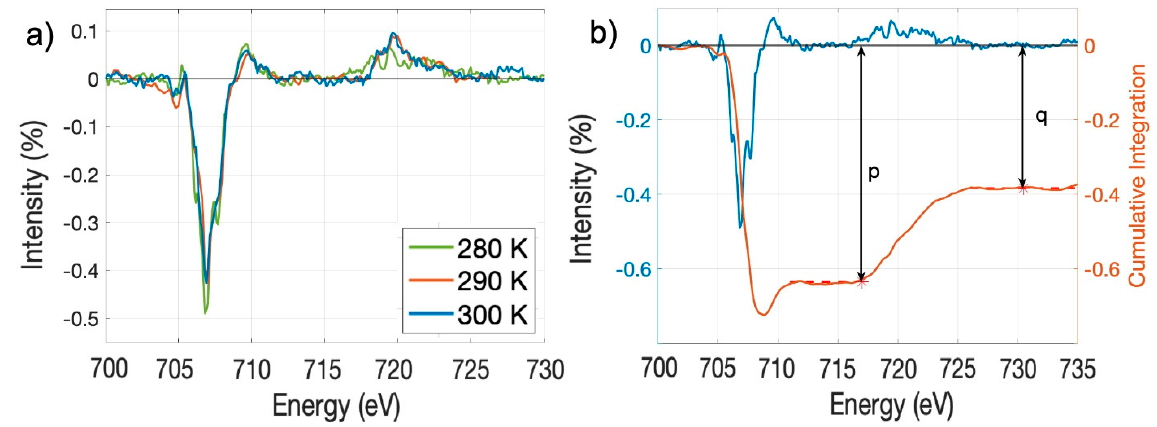
Figure 3. The Fe 2p 3/2 and 2p 1/2 (L 3 and L 2 edges) XMCD spectra of 30 nm [Fe{H 2 B(pz) 2 } 2 (bipy)] thin films on graphite. ( a ) The spectra were taken at 280 K (green), 290 K (red) and 300 K (blue). ( b ) The Fe 2p 3/2 and 2p 1/2 (L 3 and L 2 ) XMCD spectrum taken at 280 K (blue curve) compared to the integrated XMCD signal (red curve). The XMCD spectra are plotted as a percentage of the total X-ray absorption spectra.